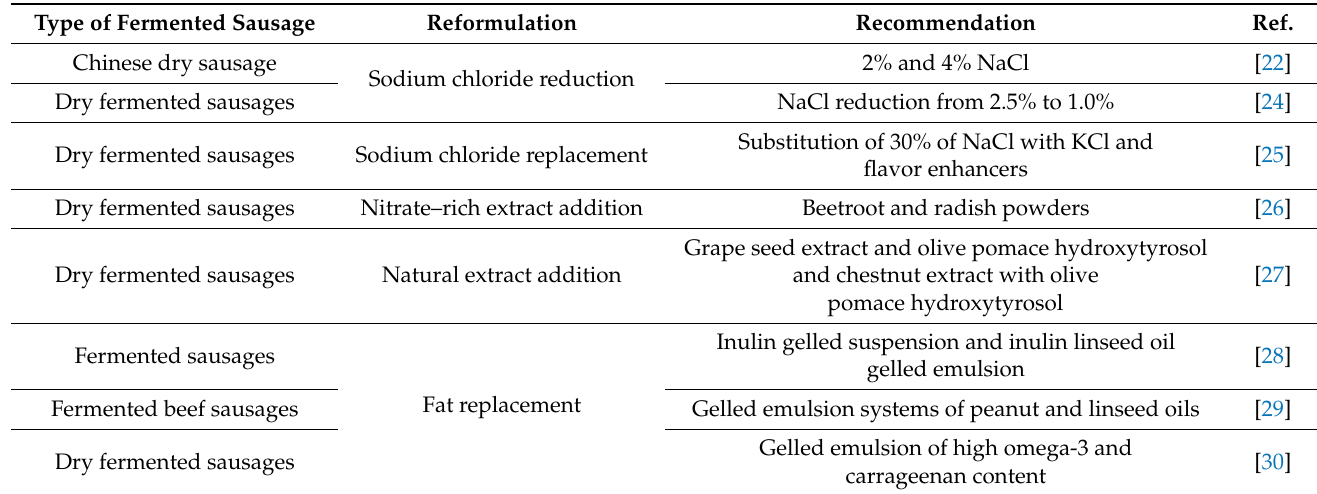
Table 1. Strategies for the reformulation of dry fermented